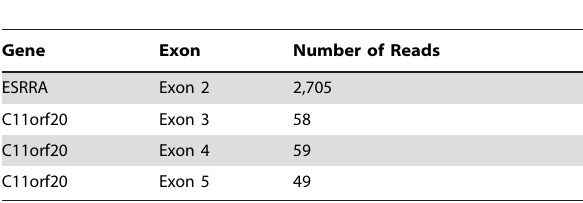
Table 1. ESRRA and C11orf20 exon reads in high-throughput data